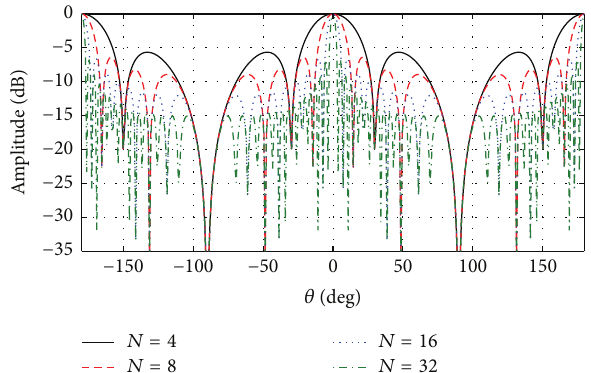
Figure 3: The number of beam lobes varies with different 𝑁 values.